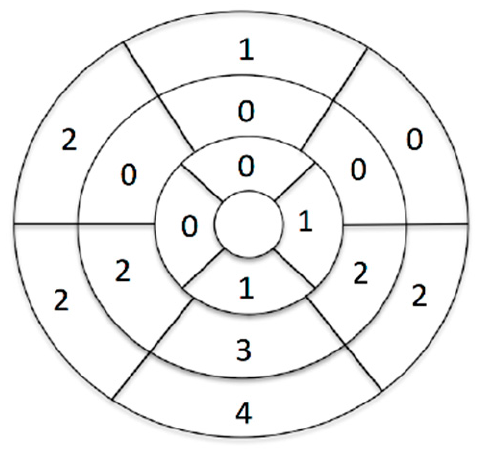
Figure 1. Number of patients with LGE in each of the left ventricular segments.